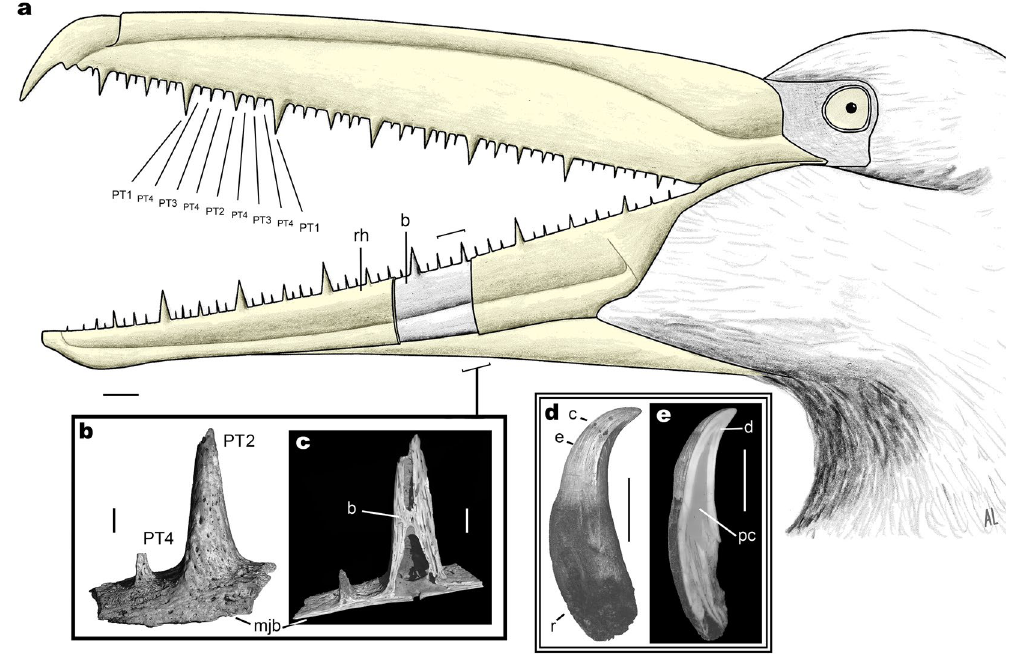
Figure 1. Schematic reconstruction of the pseudodentition of a four-ranked pseudotoothed bird. ( a ) Left view of reconstructed beak and head. The rostrum and most of the mandible are represented with the rhamphotheca (keratinized epithelium; in yellow) covering the jaw bones, except for a small area of the mandible to show the underlying bone. ( b ) Magnification of the bony cores of two adjacent pseudoteeth (the larger is a PT2, the smaller is a PT4) of Pelagornis mauretanicus (AaO-PT-B) 5 , in lateral x-ray microtomographic view. ( c ) Structure of the pseudoteeth bony cores in ( a) , shown in parasagittally truncated x-ray microtomographic view. ( d and e ) (double frame), true tooth of the Cretaceous bird Hesperornis regalis (YPM.1206B) 22 for comparison with pseudoteeth (in volume and parasagittally truncated synchrotron x-ray microtomographic views, respectively). Proportions based on data from Pelagornis species such as P. mauretanicus 5 . Views in inserts are reversed, except ( c ), in order to fit a left mandibular placement in lateral view. The real position (left vs. right, rostral vs. mandibular) of the P. mauretanicus pseudoteeth and the H. regalis tooth, shown in inserts ( b – e ), is indeterminate 5,22 . Distribution of PT1s to PT4s is indicated along part of the rostrum. b, bone; c, crown; d, dentin; e, enamel; mjb, main jaw bone; pc, pulp cavity; r, root; rh, rhamphotheca. Scale bars, main frame 2 cm, inserts ( b – e ) 2